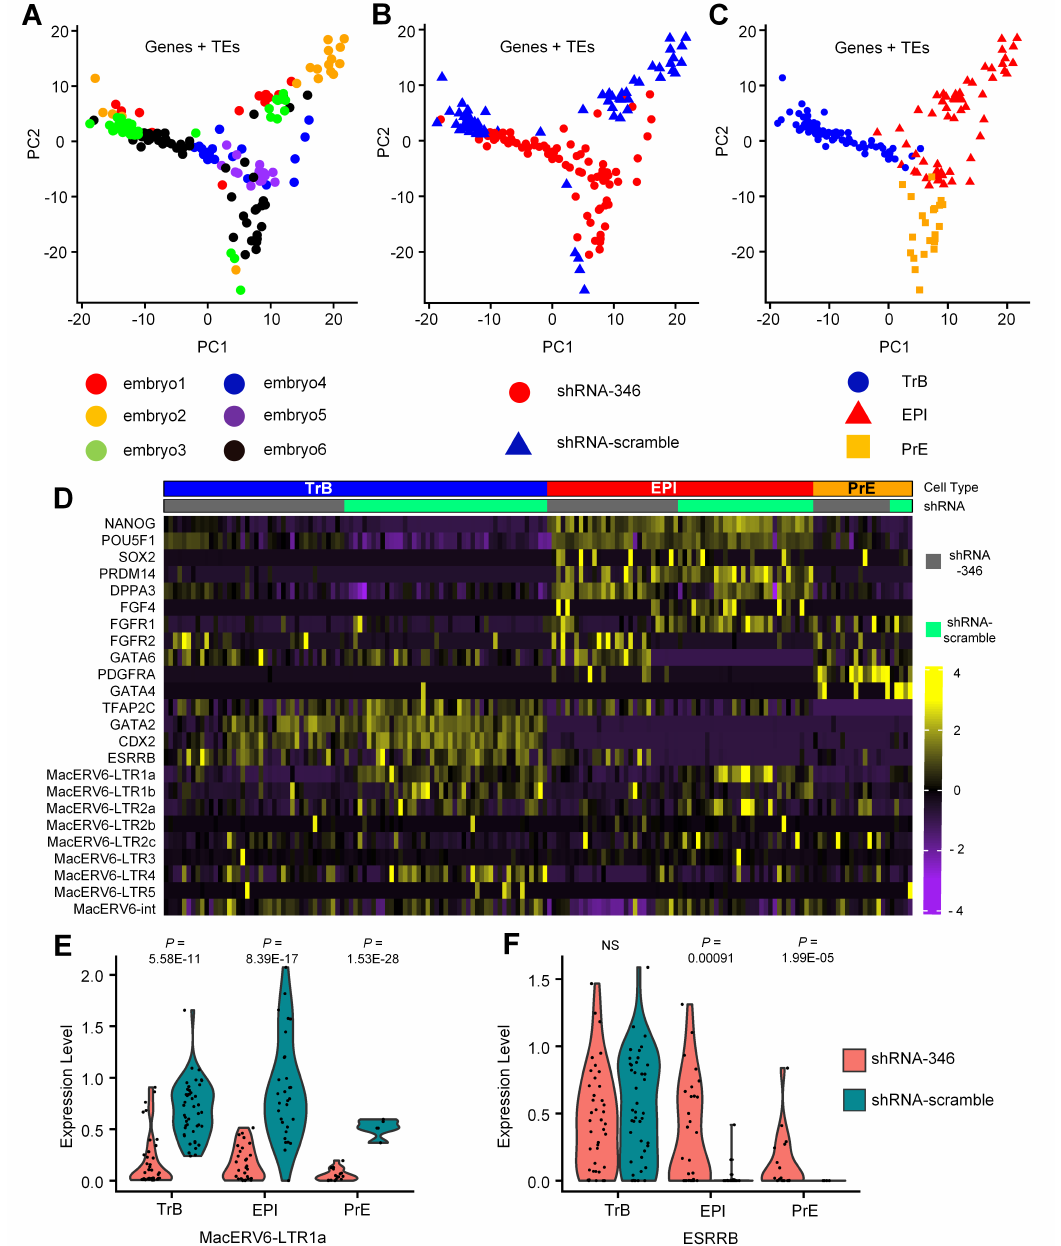
Figure 4. Transcriptional changes in shRNA-346- and shRNA-scramble-treated cynomolgus monkey embryos at day 7. ( A – C ) Principal component analysis (PCA) of single cells of embryos according to the expression of genes and TEs. ( A ) The distribution of single cells from six embryos, of which three were the control group (treated with shRNA-scramble, embryo1, embryo2, embryo3) and three were the experimental group (treated with shRNA-346, embryo4, embryo5, embryo6). ( B ) The distribution of single cells of embryos treated with shRNA-scramble (blue triangle) or shRNA-346 (red circle). shRNA-346 represents embryonic cells infected by shRNA-346 lentivirus, whereas shRNA-scramble represents embryonic cells infected by shRNA-scramble control lentivirus. ( C ) Single cells of embryos were annotated as three lineages: TrB, EPI, and PrE, according to the expression of the marker gene in part D . ( D ) Heatmap of selected marker genes. NANOG , OCT4 , PRDM14 , and DPPA3 for epiblast (EPI), GATA4 and PDGFRA for primitive endoderm/hypoblast (PrE), CDX2 and GATA2 for trophectoderm (TrB). ( E ) Vinplots of MacERV6-LTR1a expression in TrB, EPI, and PrE cells that were treated with shRNA-346 and shRNA-scramble lentivirus. ( F ) Vinplots of ESRRB expression in TrB, EPI, and PrE cells that were treated with shRNA-346 and shRNA-scramble lentivirus. NS, not significant. Furthermore, see Figure